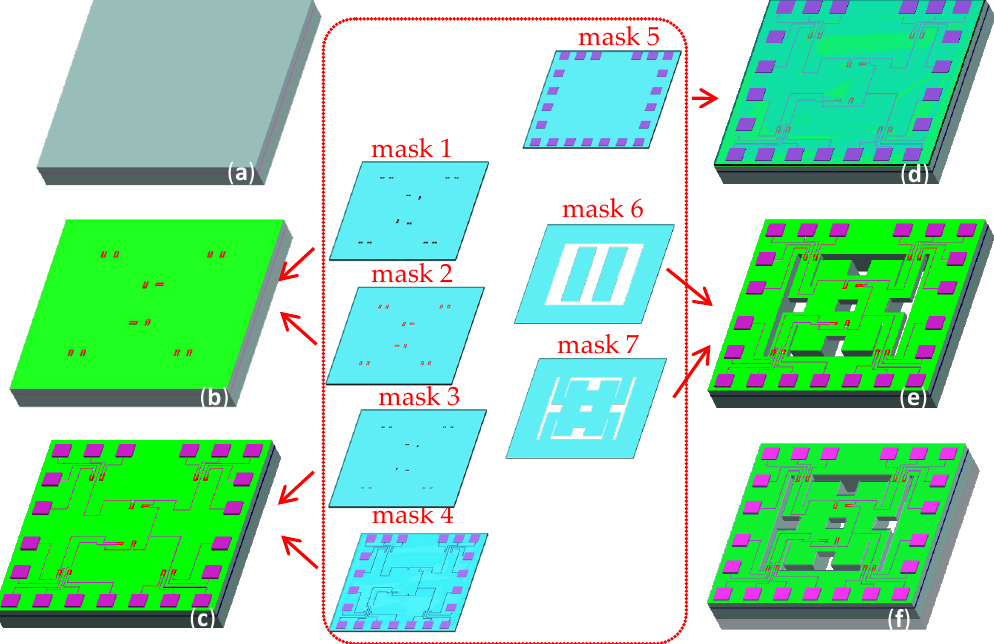
Figure 5. The main fabrication process of the proposed chip: ( a ) cleaning SOI wafer; ( b ) forming p- and p+ region; ( c ) forming contact hole and etching Al to form electrode; ( d ) forming pad; ( e ) etching the chip by inductively-coupled plasma (ICP) etching technology to form beam; and ( f ) bonding the back of the chip to the glass with hole.